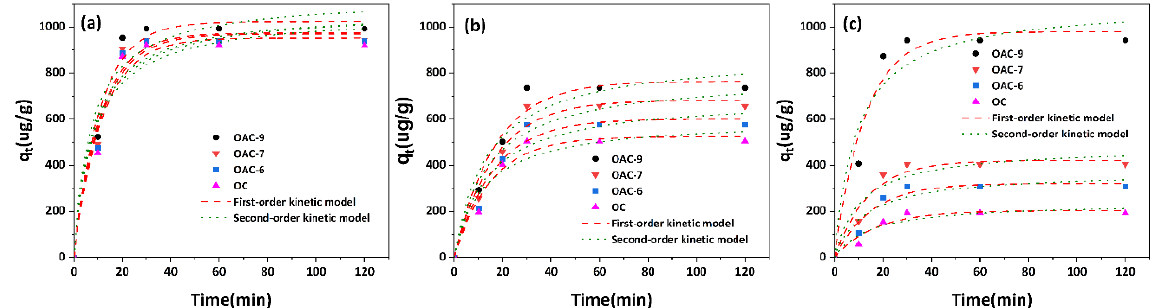
Figure 8. Adsorption kinetic of the adsorbents for 10 mg L − 1 of ( a ) MB, ( b ) TC, and ( c ) NaFL.